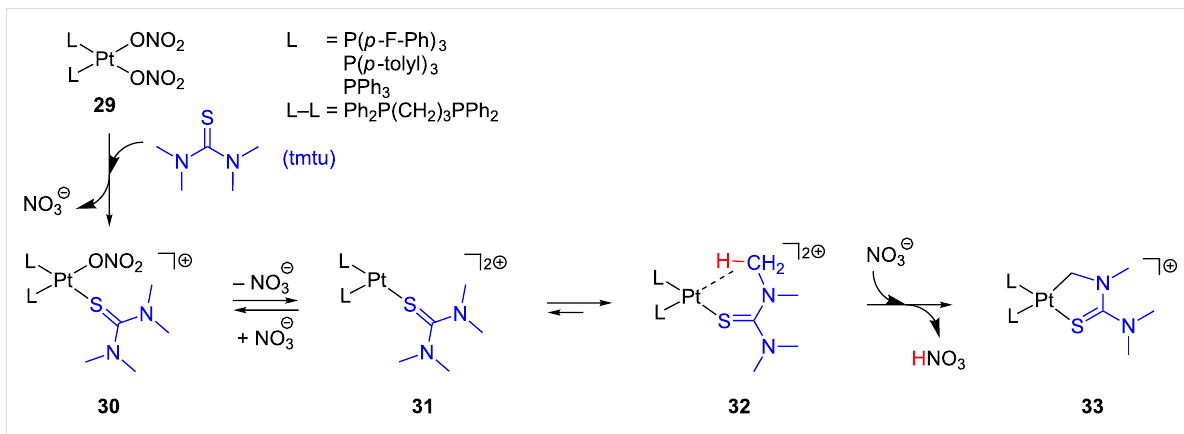
Figure 17: Gibbs energy profile (in chloroform solvent) for the cyclometalation of 23 [120].